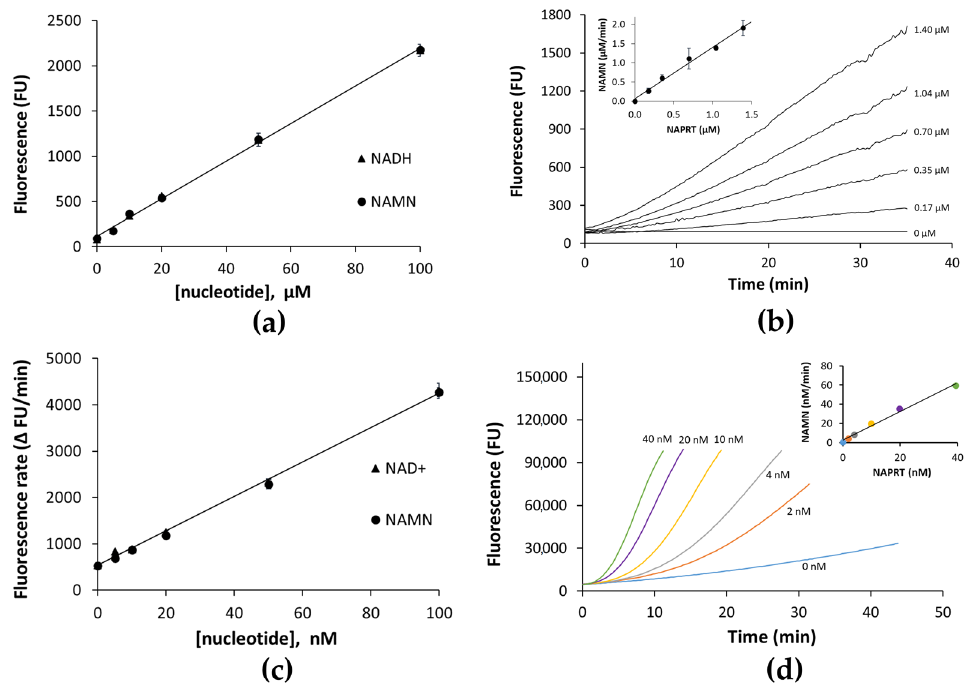
Figure 2 . Optimization of NADH assay ( a , b ) and resazurin/diaphorase assay ( c , d ). ( a ) Stoichiometry conversion of NAMN to NADH. Various amounts of NAMN or NADH were incubated as described in the text, and fluorescence values were plotted against the nucleotides’ concentrations. ( b ) Time course of fluorescence increase in reaction mixtures containing various NAPRT concentrations. The linear correlation between NAMN formation and NAPRT concentration is shown in the inset. ( c ) Various amounts of NAMN and NAD + were incubated in the resazurin/diaphorase assay mixture as described in the text, and the rates of fluorescence increase were plotted against the nucleotides’ concentrations. ( d ) Time dependence of the fluorescence increase at various NAPRT concentrations.